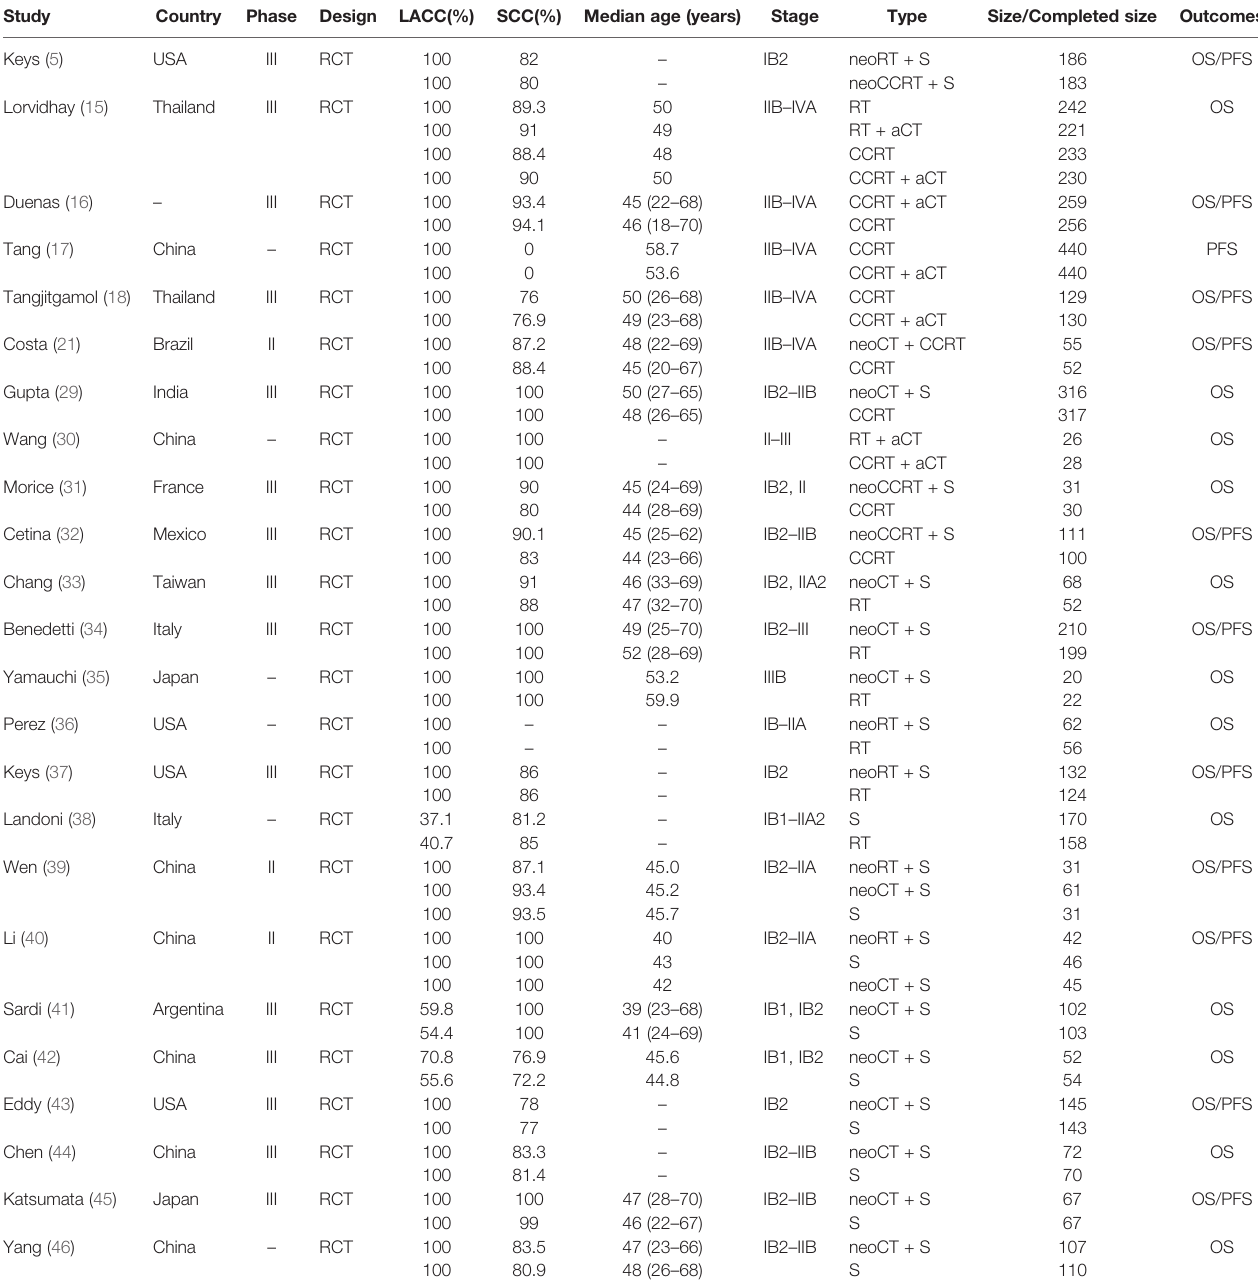
TABLE 1 | Summary of the studies included in the meta-analysis.